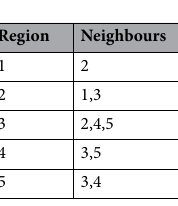
Table 1. A five regions queen contiguity